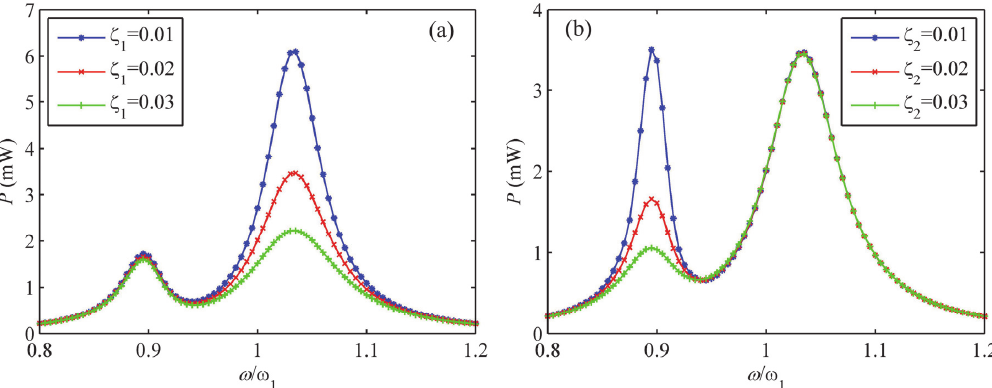
Figure 7. Output power versus excitation frequency for different mechanical damping ratios: ( a ) ζ 1 ; ( b ) ζ 2 .